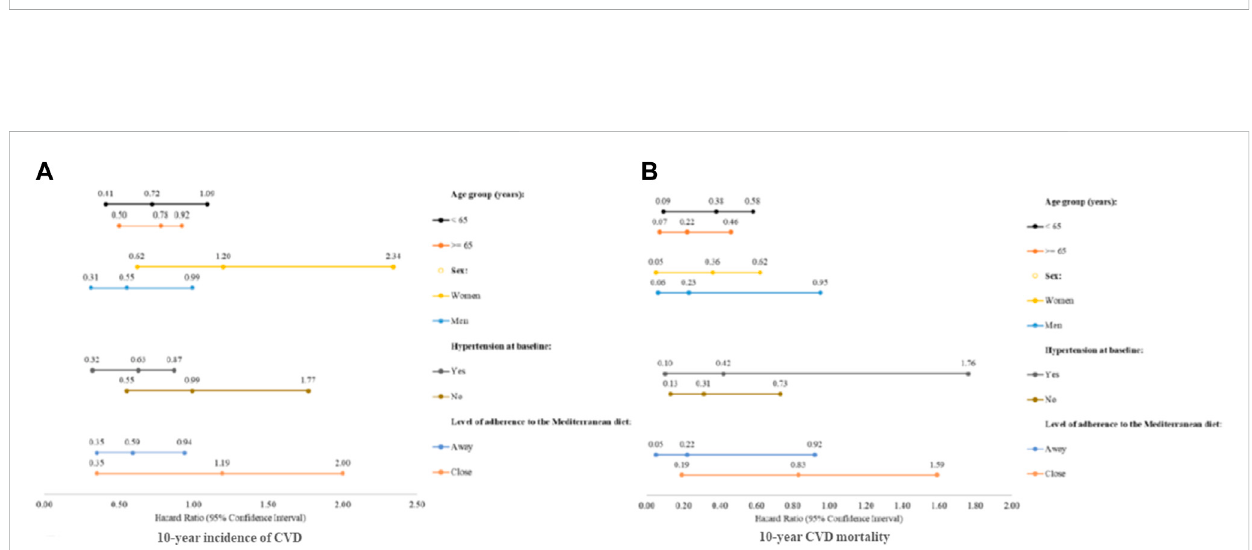
FIGURE 2 HazardRatio(HR)and95%Con fi denceInterval(95%CI)forfataland/ornon-fatal10yearCVDeventsaccordingtotheweeklyconsumptionofsmall fi sh rich in omega 3 fatty acids, strati fi ed by participants ’ age, sex, adherence to the Mediterranean diet, and history of hypertension: The ATTICA Cohort Study, 2002-2012. (A) Total weekly consumption of small fi sh rich in omega 3 fatty acids in relation to 10 year incidence of CVD. (B) Total weekly consumption of small fi sh rich in fatty acids in relation to CVD mortality. The results are based on multivariable Cox proportional hazard model, adjusted for demographic characteristics (including age (years), sex, and highest educational level attained), lifestyle and anthropometric characteristics [including smokinghabits(currentsmokervsnon-smoker/formersmoker),physicalactivity(activevssedentary),andBMI(kg/m 2 )],familyhistoryofCVD (yes vs no), and personal history of diabetes mellitus, hypercholesterolemia, and/or hypertension (yes vs